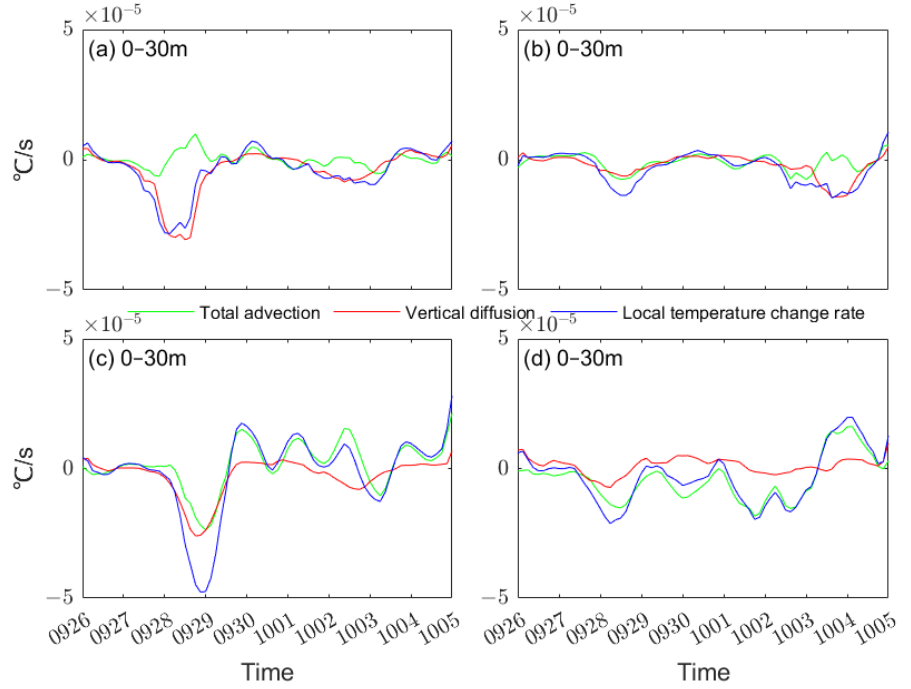
Figure 9. ( a – d ) Average heat budget of 0–30 m at S1, S2, S3, and S4.